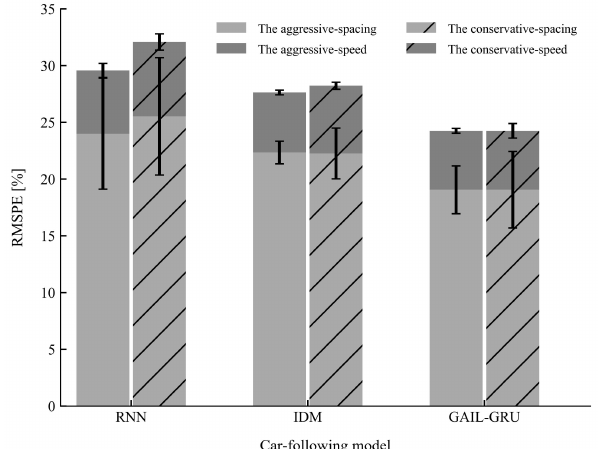
Figure 13. Mean and standard deviation of the root mean square percentage error (RMSPE) on the test sets for the three models.